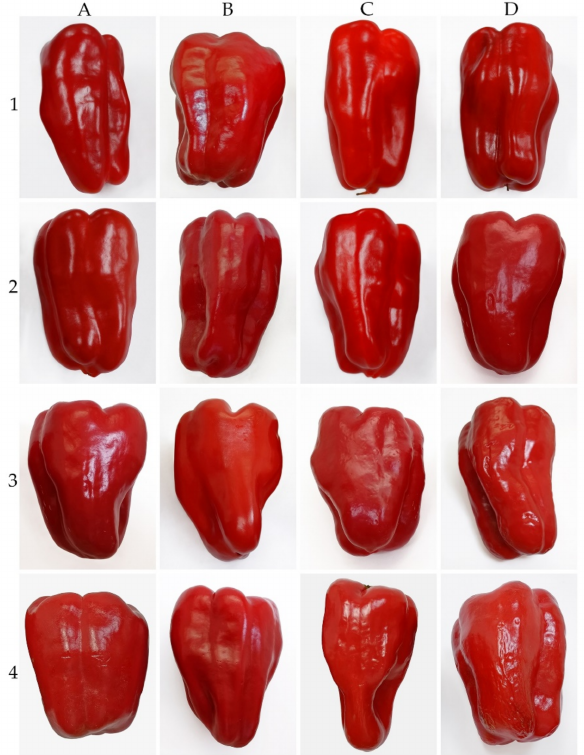
Figure 2. Effect of hot water treatment at 55 ◦ C for ( A ) 0 min (control), ( B ) 1 min, ( C ) 3 min, and ( D ) 5 min on virtual symptoms of CI in red sweet pepper fruit during storage at 10 ◦ C for 4 weeks (1, 2, 3,